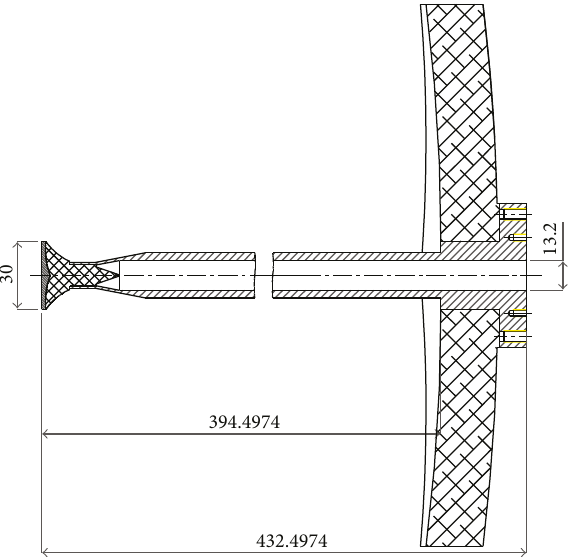
Figure 2: Structure of the main and side re fl